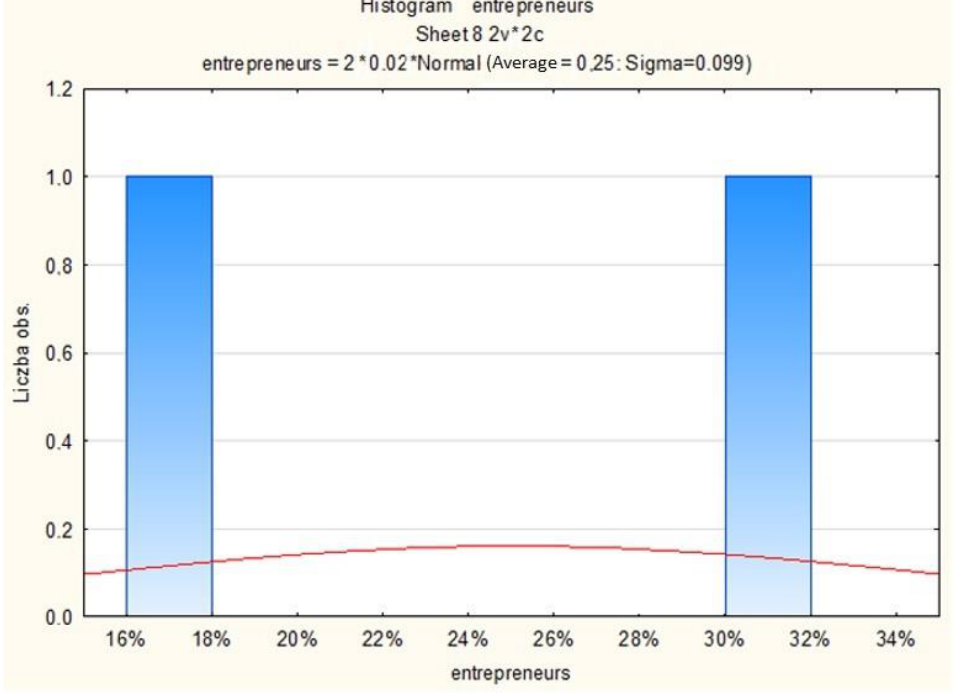
Figure 20. Structure of the participation of entrepreneurs in the survey.